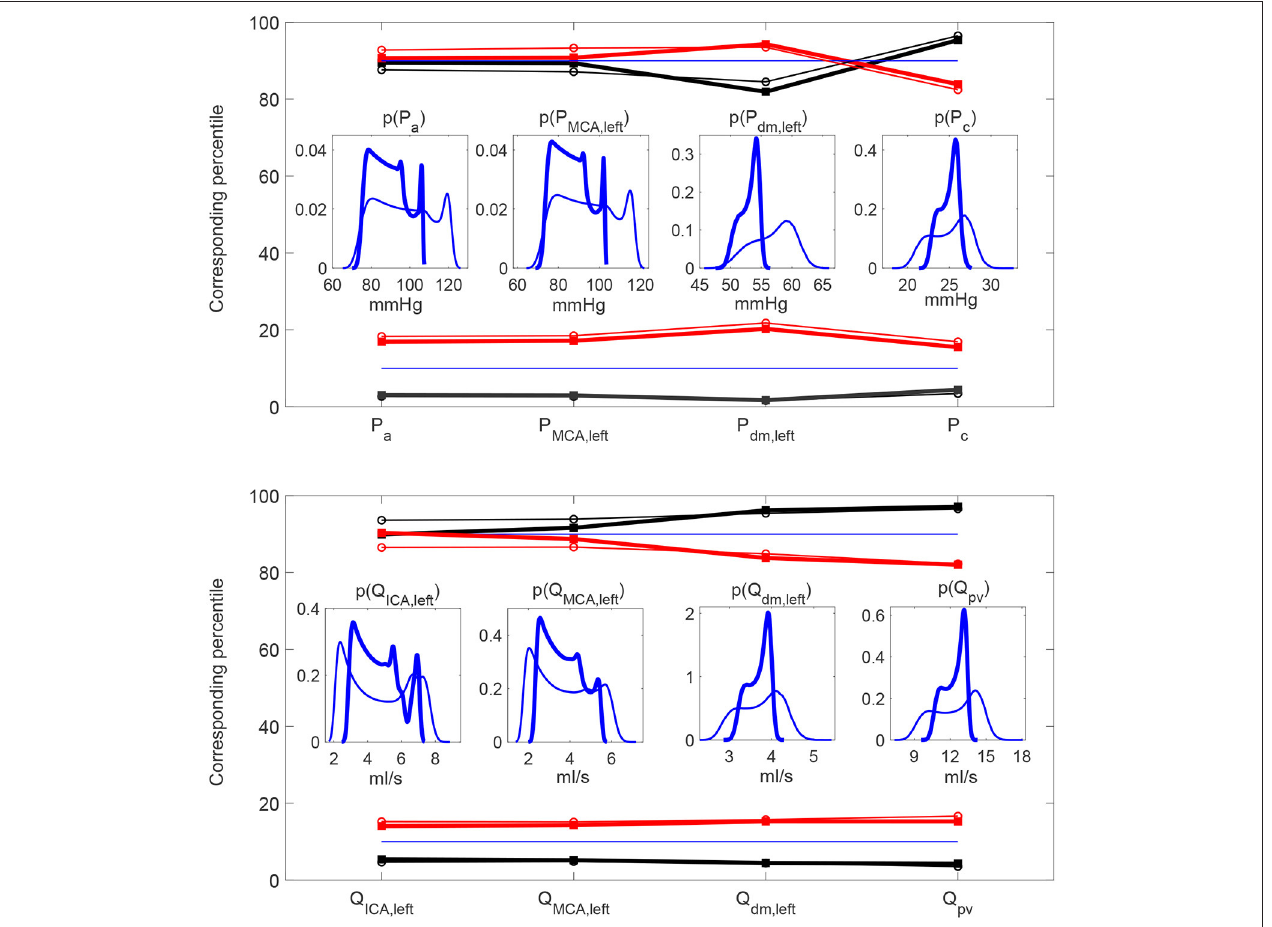
FIGURE 9 | Heart failure (thick) vs. healthy (thin) percentile analyses. Percentile values in increased (red) and decreased (black) HRV to which the 10th and 90th percentiles in baseline configuration correspond. Pressure (Top) and flow rate (Bottom) along the ICA-MCA pathway. Inset panels represent the PDFs of the continuous hemodynamic